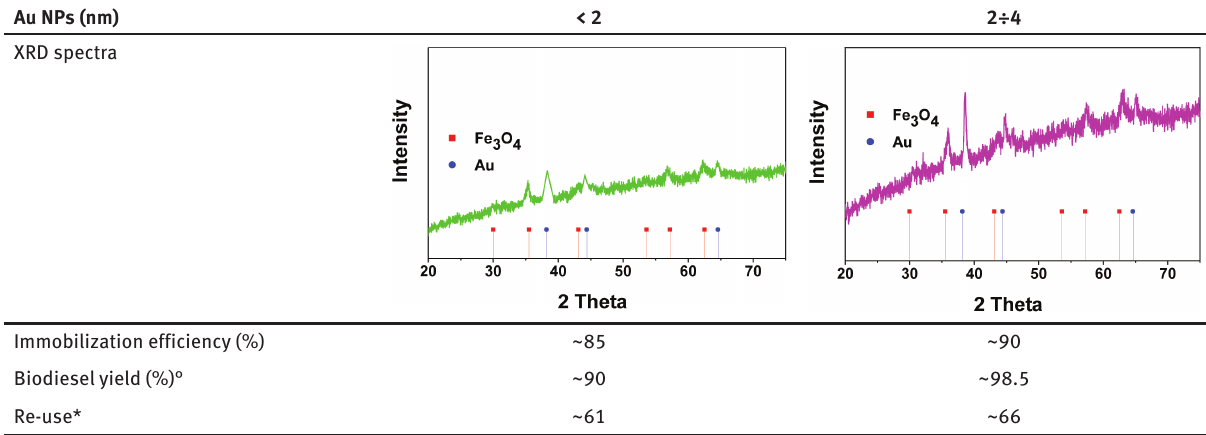
O for enzyme immobilization and biodiesel production. Table 3: Effect on size of Au on Fe 3 4 Au NPs (nm) < 2